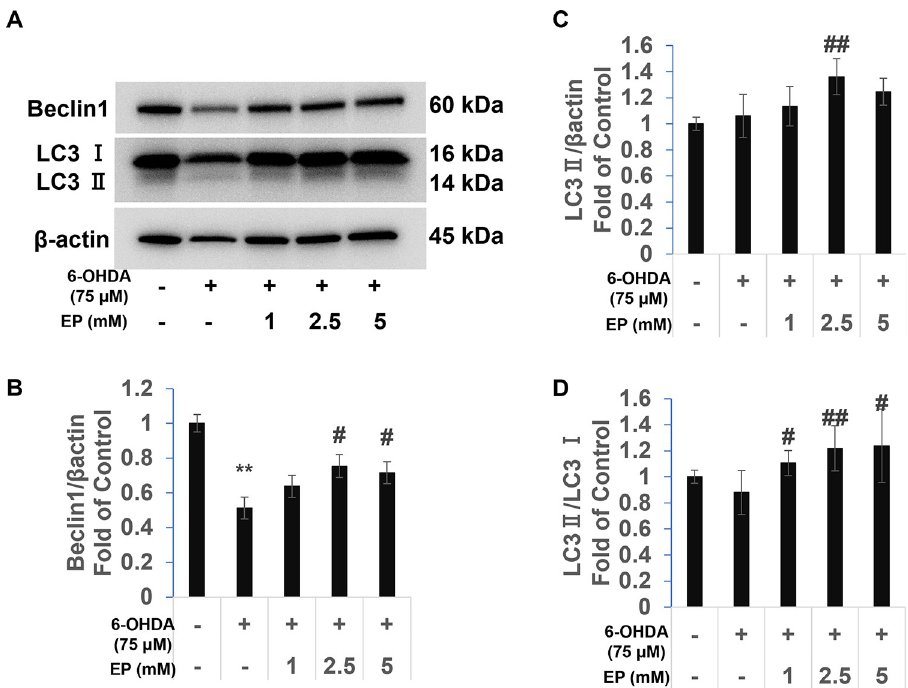
Fig 4. Effects of EP on autophagy-associated Beclin-1 and LC3 gene expression. (a) Representative western blots of LC3 and Beclin-1. Protein bands of (b) Beclin-1 and (c) LC3-II quantified by ImageJ. (d) Relative ratios of LC3-II/ LC3-I band density. Results are expressed as means ± standard deviation (N � 3) � P < 0.01 vs . control; † P < 0.05 and ‡ P < 0.01 vs . 6-OHDA).